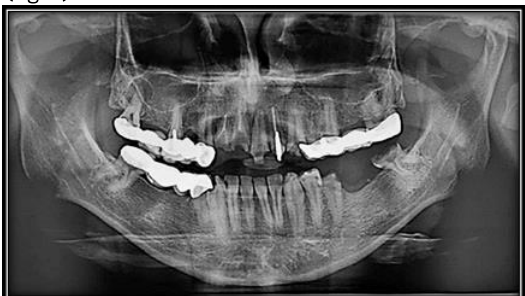
Figure 1: Diagnostic preoperative